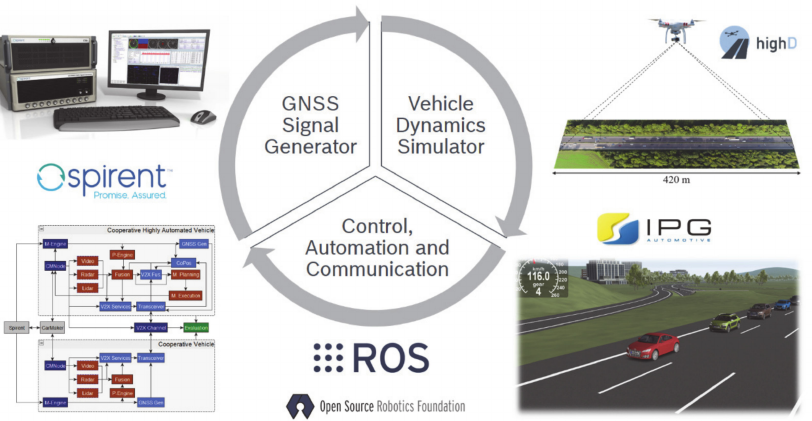
Figure 3. Overview of the main components of the simulation and testing platform TEPLITS